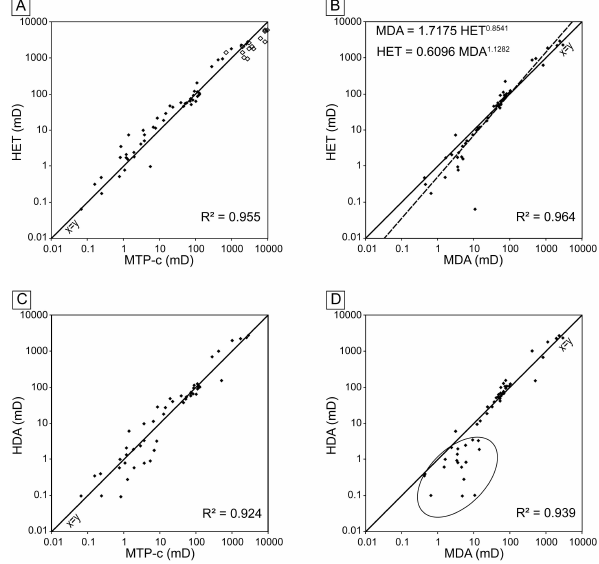
Fig. 6. Comparison of Hassler cell versus minipermeameter mea- surements: ErgoTech gas permeameter (HET) versus TinyPerm II (MTP) (A) and Miniperm Darmstadt (MDA) (B) , and the gas per- meameter in Darmstadt (HDA) versus TinyPerm II (MTP) (C) and Miniperm Darmstadt (MDA) (D) . The MTP values are corrected by − 37% (MTP-c) to compensate for reduced flow trajectories. The bisectrix ( x = y ) indicates positive or negative aberrations of the measuring results, and the dashed line indicates the regression line of the resulting transform equations for standardization. Note the bi-logarithmic scales. Outcrop and Hassler cell data from Fossen et al. (2011) are additionally shown in (A) (open diamonds, unmodi- fied MTP